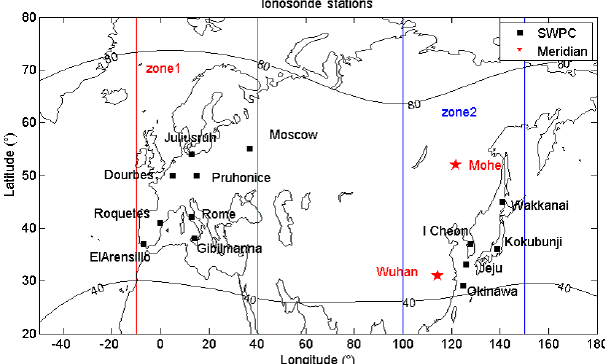
Figure 8. Distribution of ionosonde stations located in two zones. Zone 1, including eight SWPC stations, is within magnetic incli- nations of 40–80 ◦ and longitudes of − 20–40 ◦ , mainly in the Eu- rope region. Zone 2, including five SWPC stations and two China Meridian Project stations, is located within magnetic inclinations of 40–80 ◦ and longitudes of 100–160 ◦ , mainly in the East Asia re- gion. Black squares represent SWPC stations, and red stars repre- sent China Meridian Project stations.